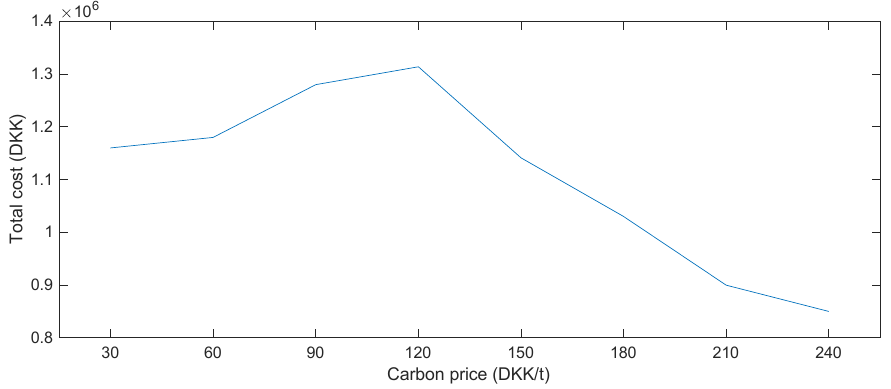
Figure 14. Total cost under different carbon trading prices.